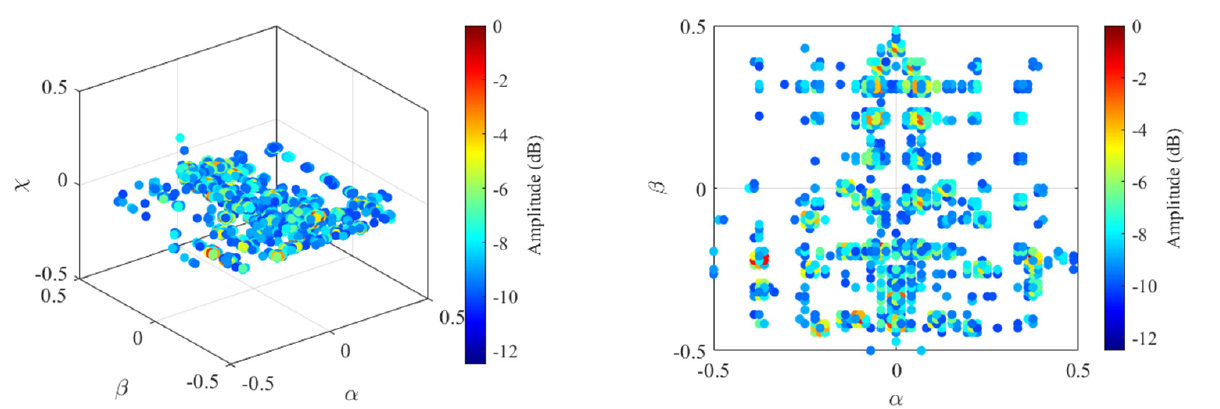
Figure 17. Target imaging result obtained by the zero-padded 3D IFFT with random sparse-sampled signal cube.